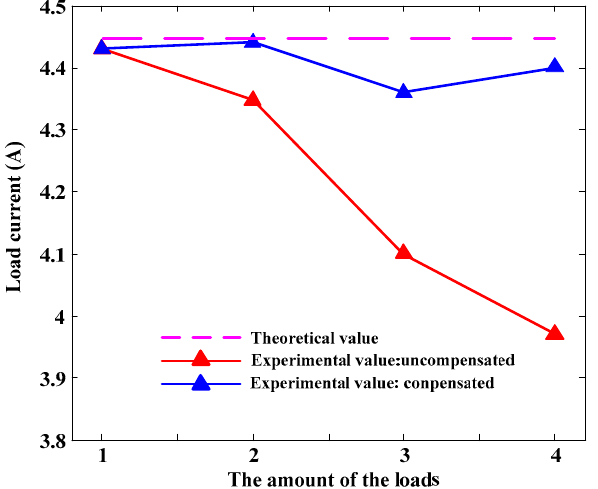
Figure 11. Change in load current with number of loads after eliminating cross-coupling using capacitance